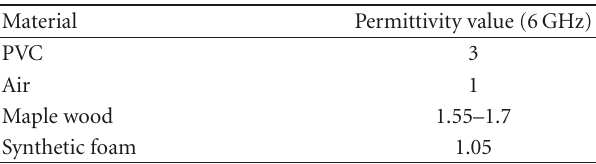
Table 1: Permittivity values of the materials used in the phantom structure and support base.